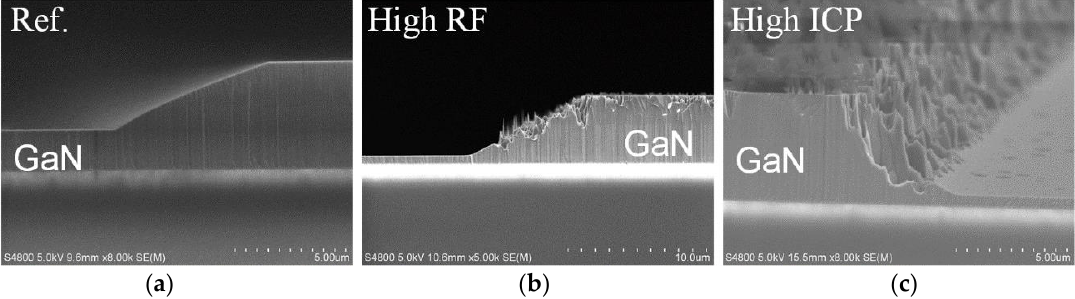
Table 2. Etched results with different hard baking temperatures.